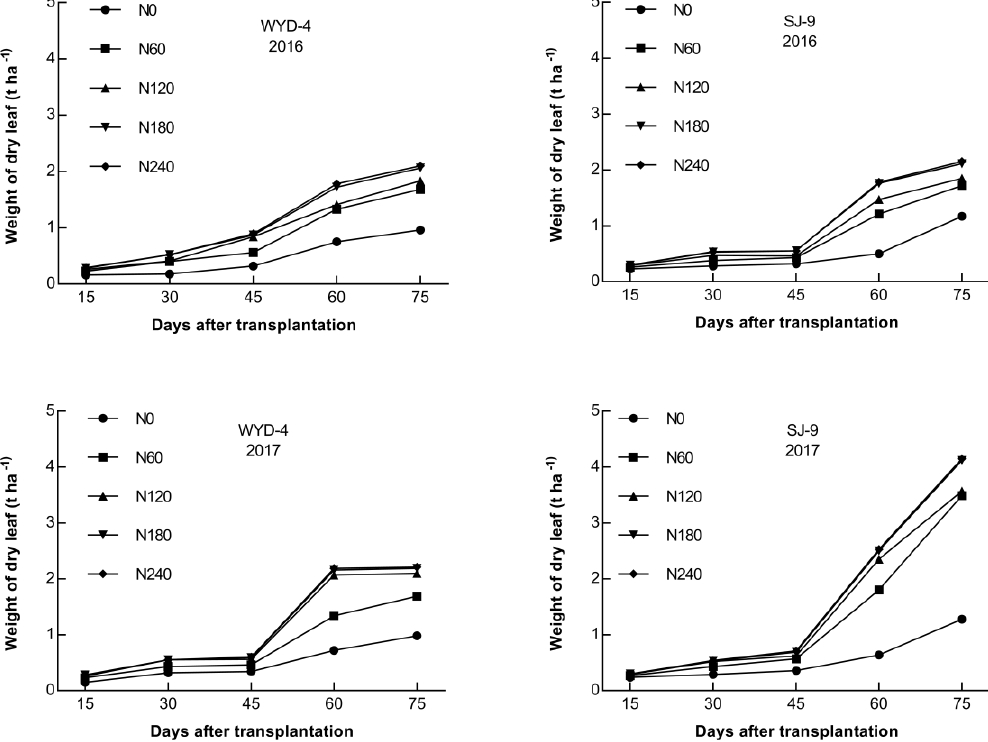
Figure 2. Changes of rice leaf dry matter (t ha − 1 ) with time (days after transplantation) under di ff erent N application rates in experiments conducted during 2016 and 2017. WYD-4 and SJ-9 refer to Wuyoudao4 and Songjing9, respectively, the same as below.